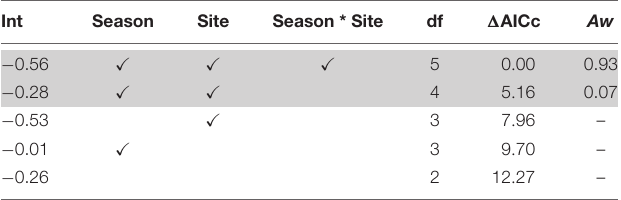
TABLE 1 | Factors influencing the probability of encountering fruit on a given fruit walk. Int